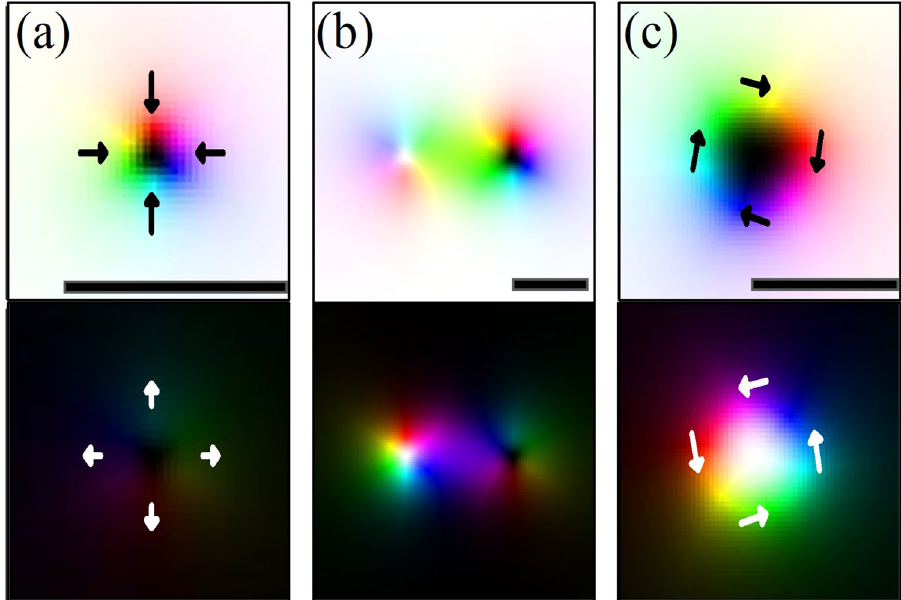
Figure 2. Stable skyrmion states built without an external field. ( a ) ‘Sole skyrmion’ state: a skyrmion is in only one layer. ( b ) Coupled ‘Sole skyrmion’ states: Two skyrmions are coupled to each other through in-plane magnetization bridge. ( c ) ‘Skyrmion pair’ state: It is neither a Bloch nor a Néel type skyrmion. The arrows of ( a , c ) indicate the magnetization direction of the rim part of the